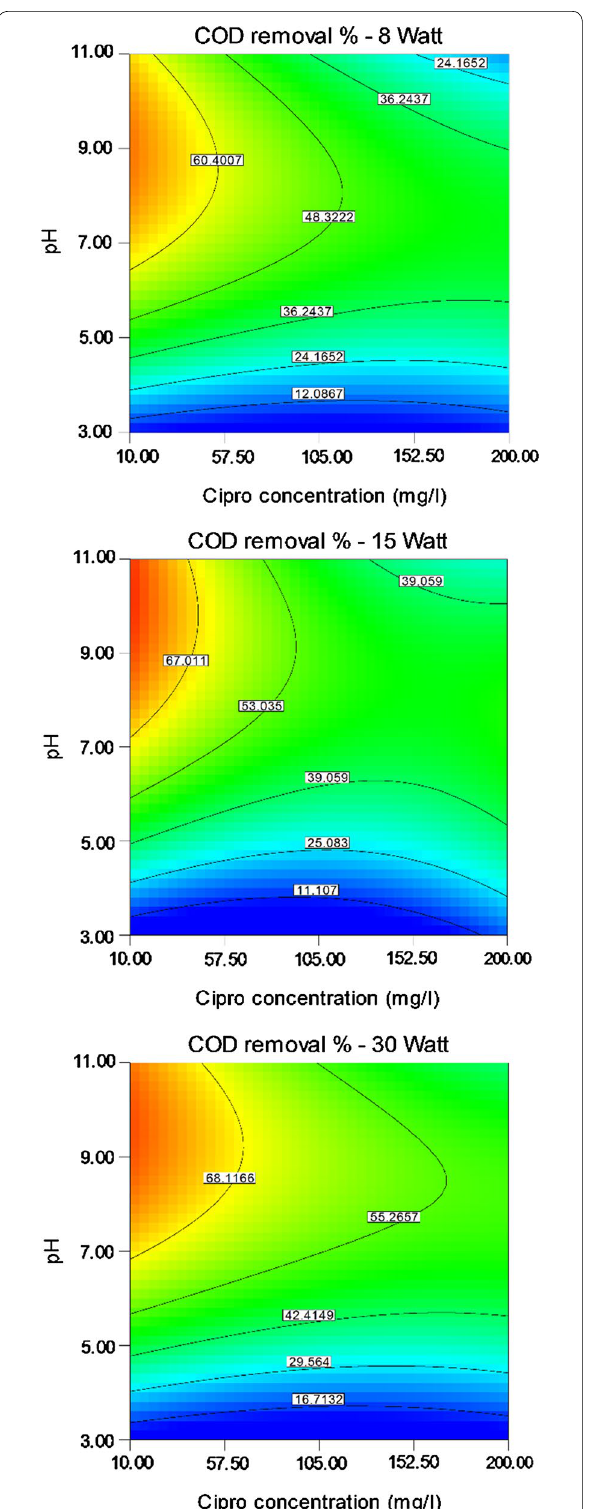
Fig. 5 Effect of Cipro concentration and solution pH on COD removal efficiency